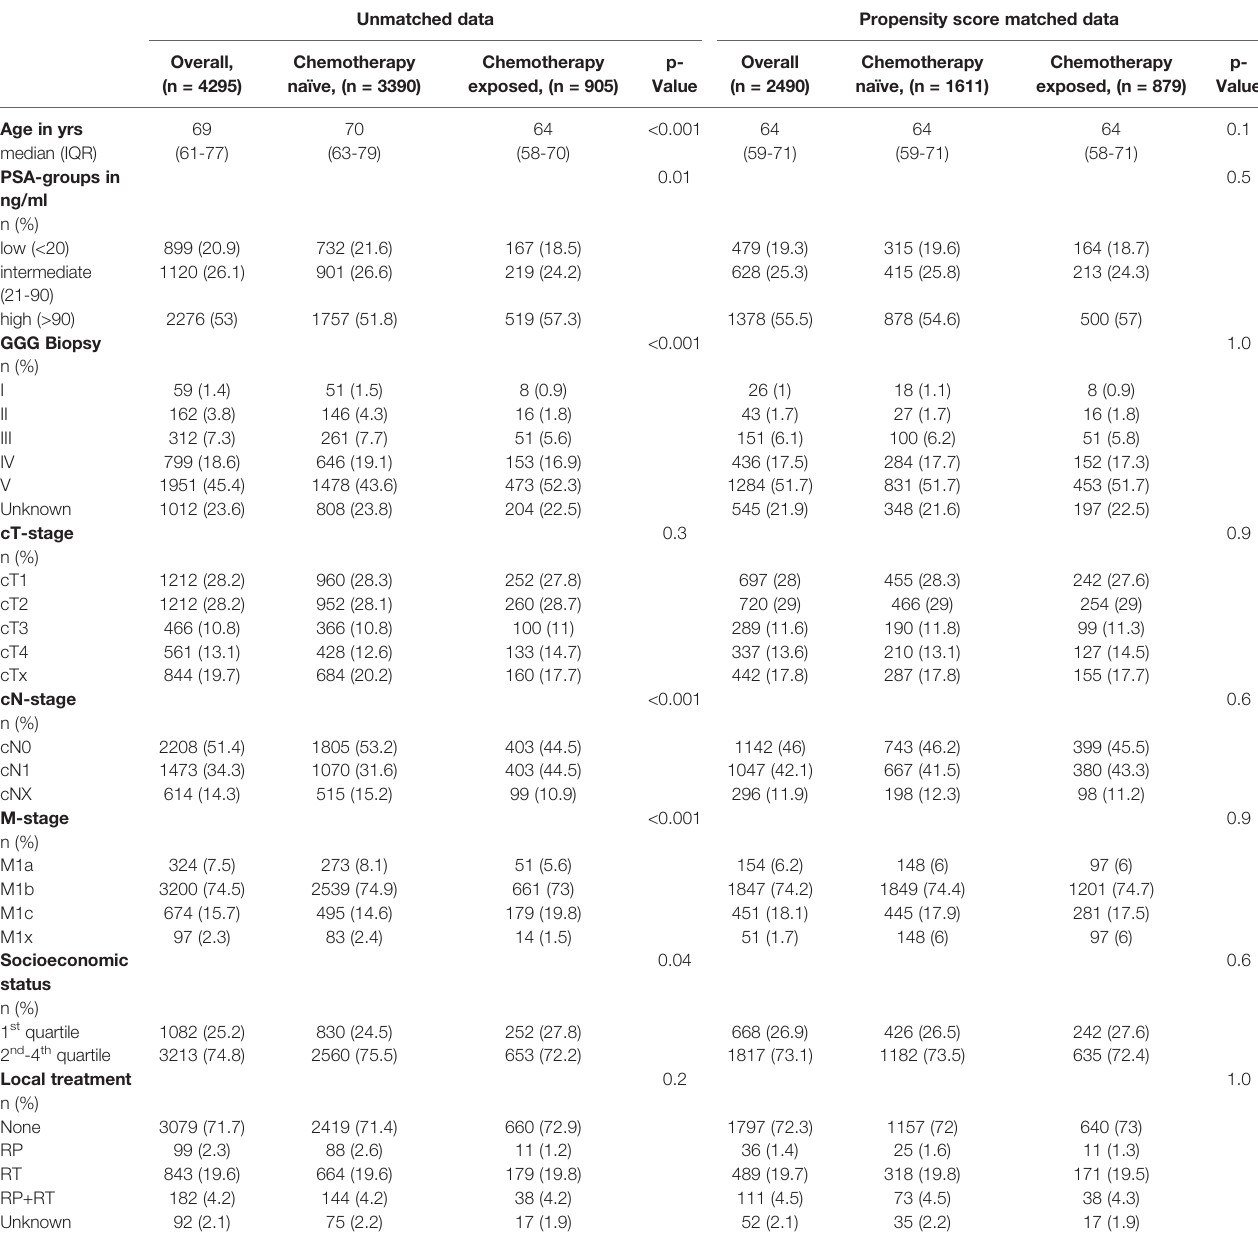
TABLE 1 | Descriptive characteristics of de novo metastatic prostate cancer patients between 2014 and 2015, strati fi ed by chemotherapy exposure. Unmatched